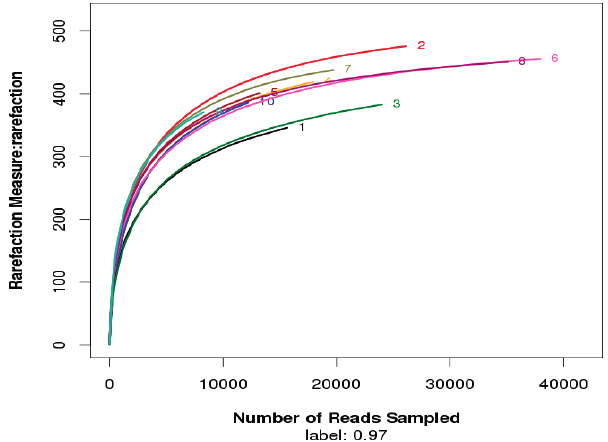
Figure 2. Rarefaction curves of the operational taxonomic units (OTUs) number at 97% similarity boxplot for vertical distribution of bacterial community during JINPEN drinking water reservoir thermal stratification. 1, 2, 3, 4, 5, 6, 7, 8, 9, and 10 represent 0.5, 5, 10, 20, 25, 30, 45, 50, 55, and 65 m depths, respectively.